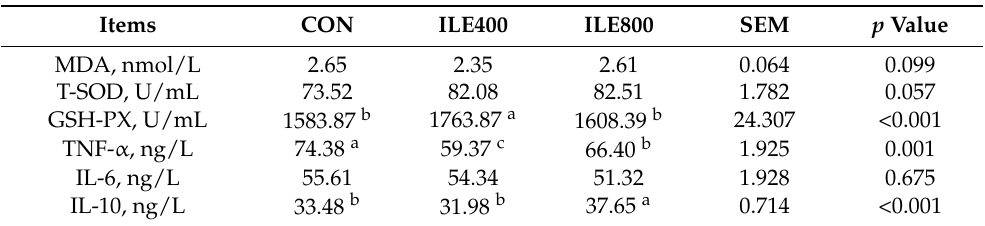
Table 5. The effects of dietary supplementation with isoleucine (Ile) on the serum antioxidants and inflammatory factors of broiler